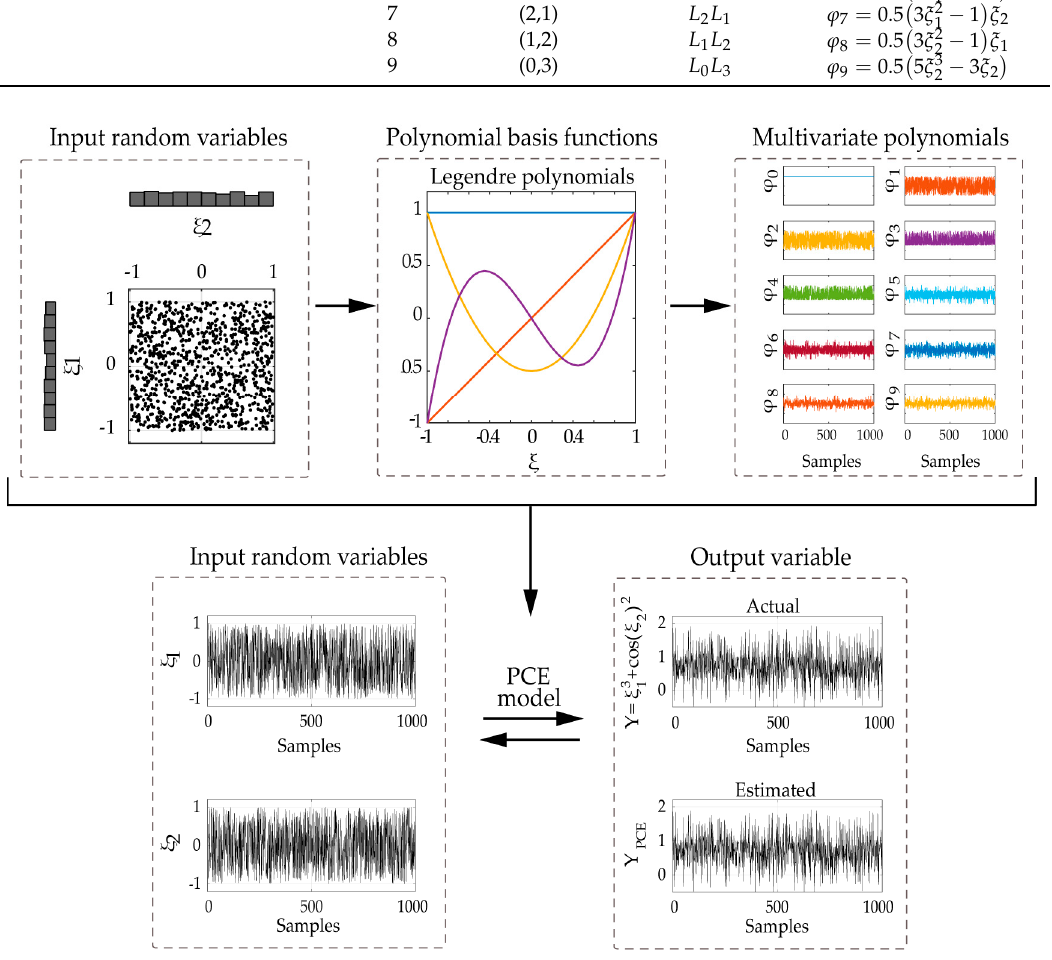
Figure 4. Schematic overview of the PCE method: example of two independent input random variables (cid:2022) (cid:2869) , (cid:2022) (cid:2870) with uniform pdf and a system output variable (cid:1851) = (cid:2022) (cid:2869)(cid:2871) + cos ((cid:2022) (cid:2870) ) (cid:2870) .